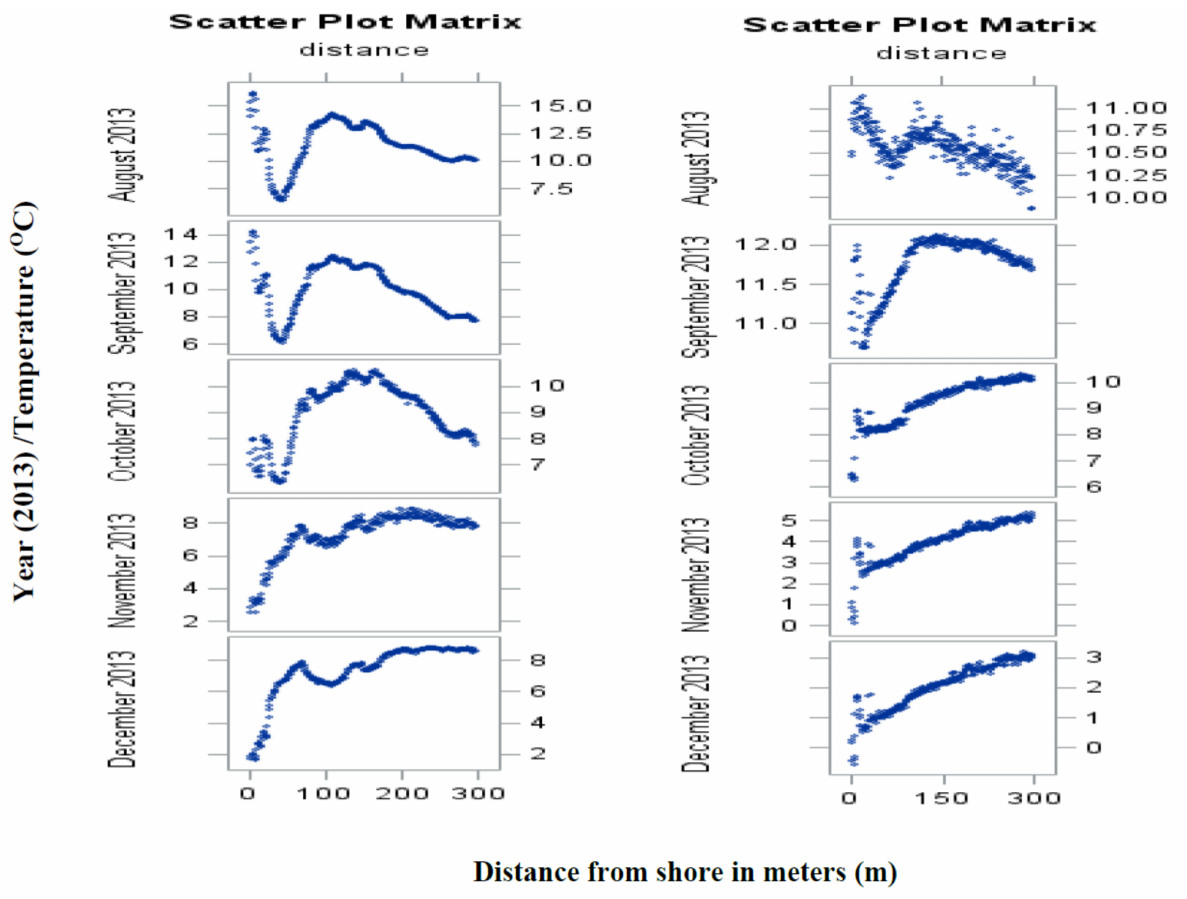
Figure 10. Scatter plot matrix showing the months of the year in 2013 vs. distance for both sites at Suvilahti in the city of Vaasa. Ketunkatu ( left ) and Liito-oravankatu ( right